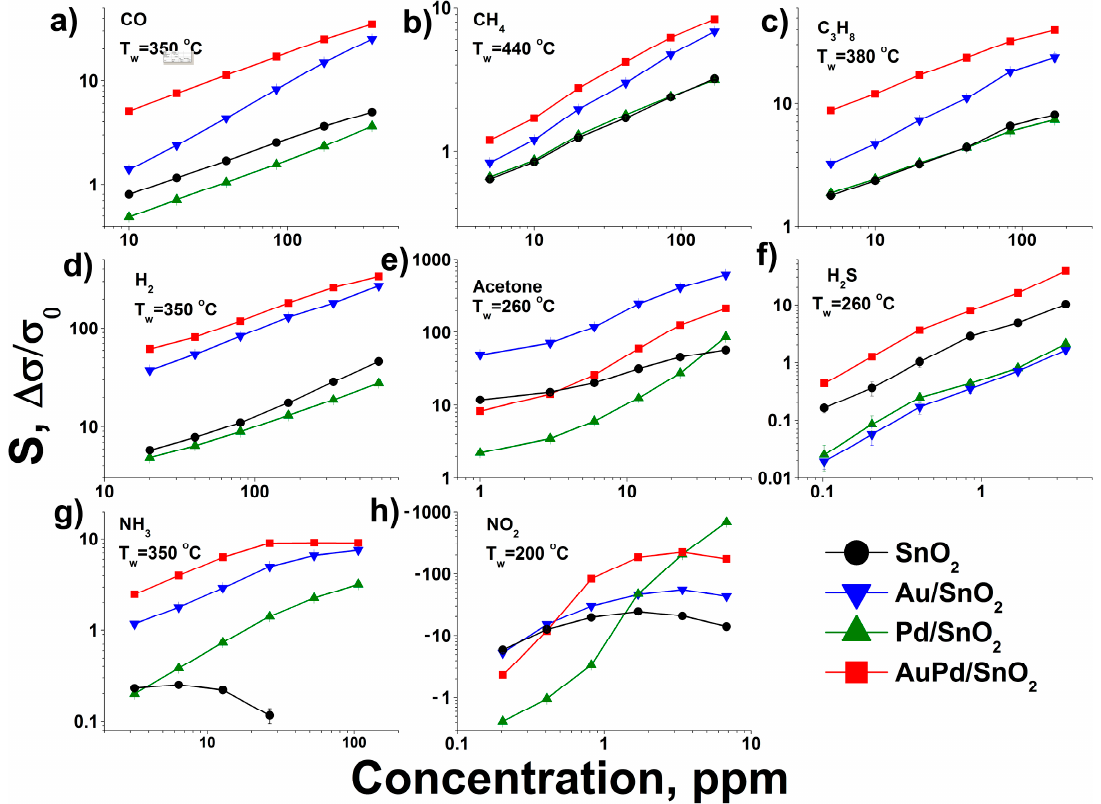
Figure 6. Dependence of gas sensor response of synthesized materials on gas concentration at maximum response working temperature for AuPd/SnO 2 material: ( a ) CO ( b ) CH 4 ( c ) C 3 H 8 ( d ) H 2 ( e ) acetone ( f ) H 2 S ( g ) NH 3 ( h ) NO 2 in dry air. Table 3. Limits of detection of the sensors on the basis of the synthesized materials.